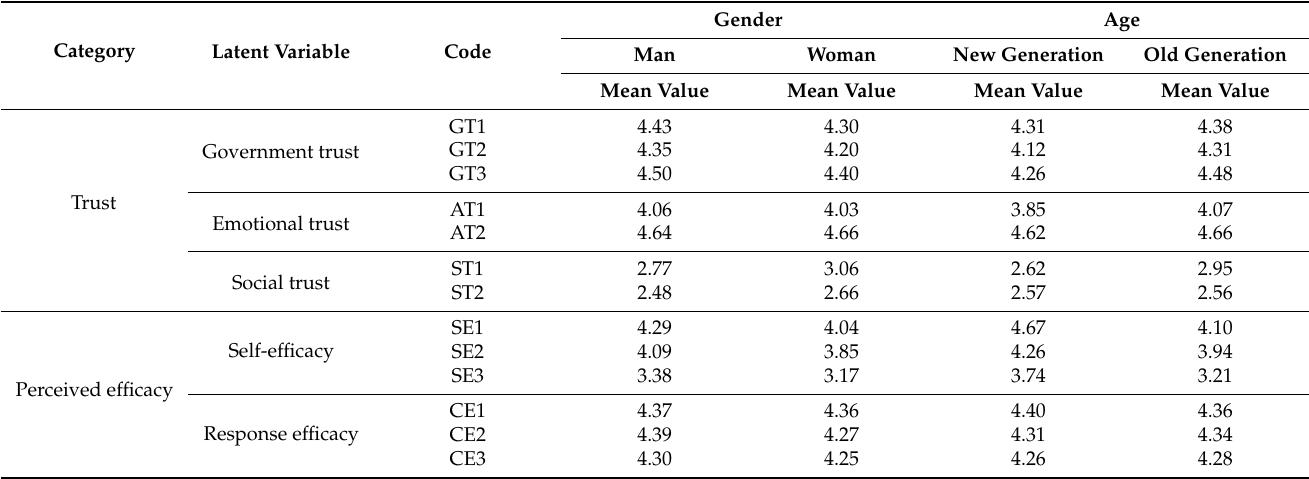
Table 3. Statistical tables of core variables for different ages and genders.